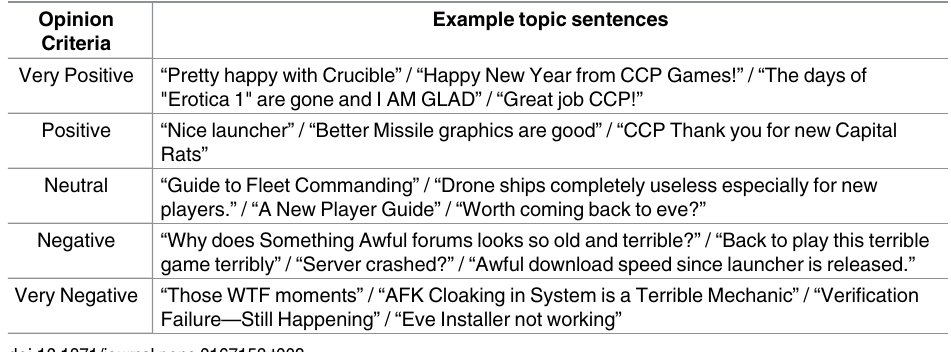
Table 2. EVE Online Forum Opinion Analysis